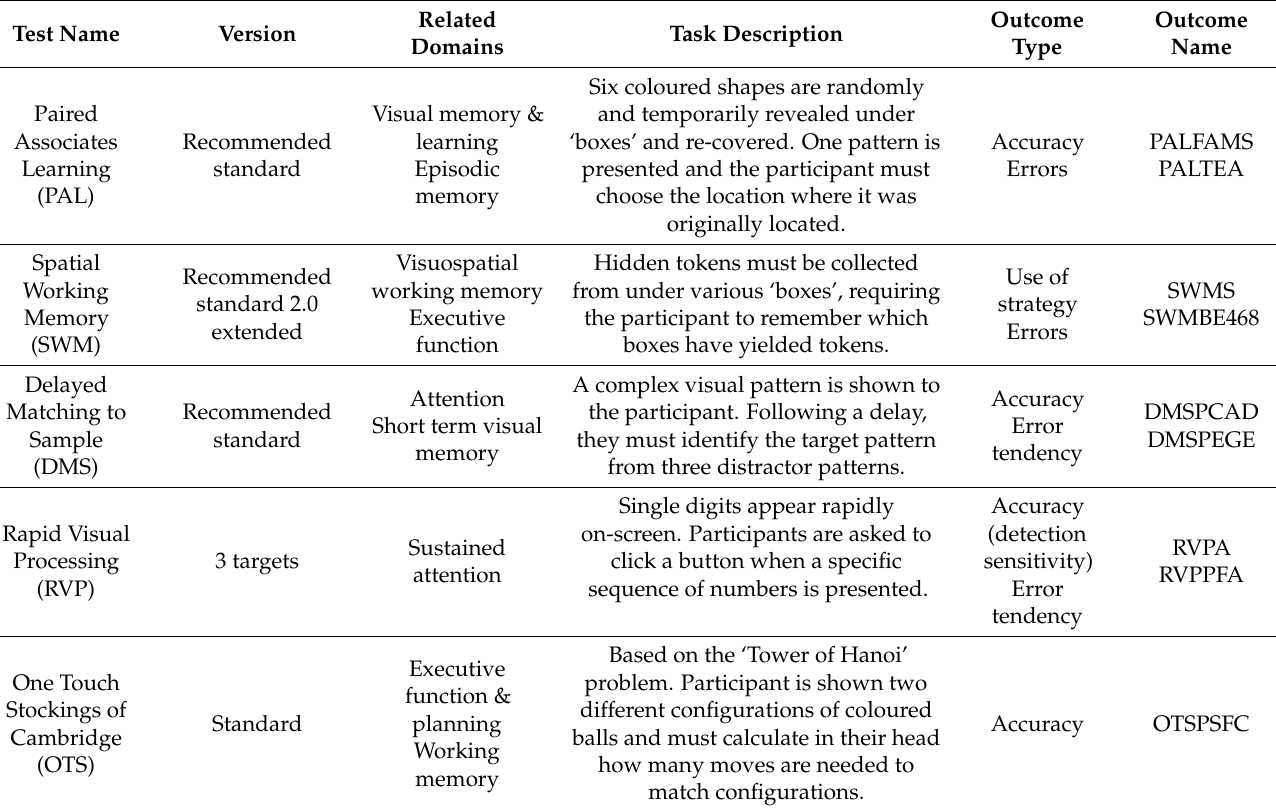
Table A1. Summary of CANTAB tasks and outcome measures used in the cognitive test